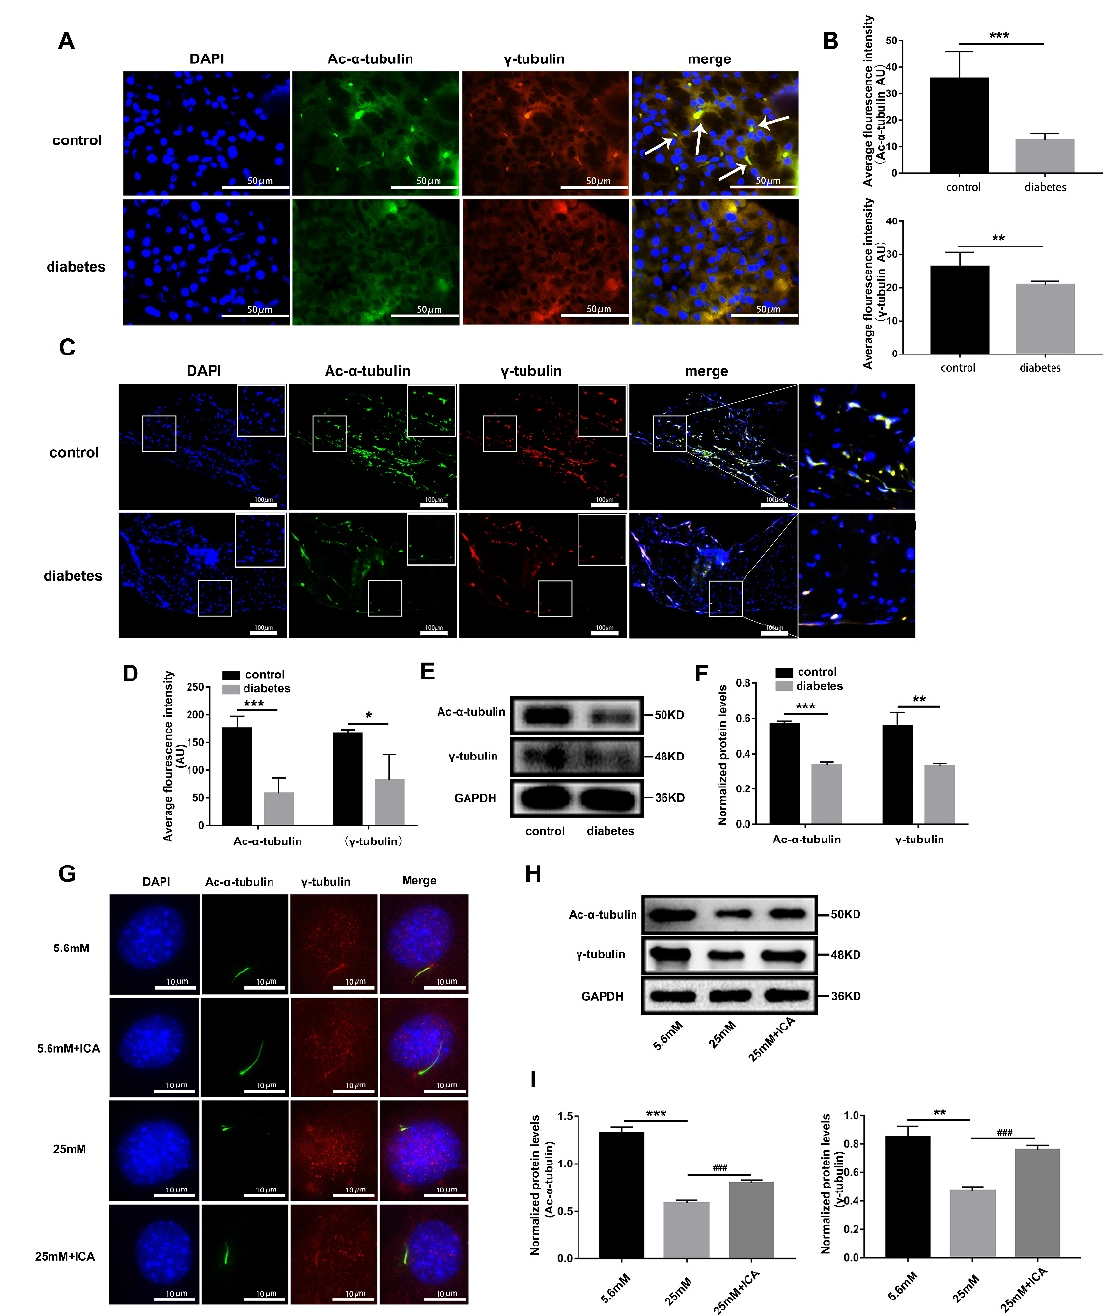
Figure 4. Diabetes impairs primary cilia in bone tissue, and ICA could protect the primary cilia from high glucose damage. ( A ) Immunofluorescence of pancreas, scale bar: 50 μ m. ( B ) Quantitative analysis average fluorescence intensity of Ac- α -tubulin and γ -tubulin in ( A ). ( C ) Immunofluorescence of femur tissue, scale bar: 100 μ m. ( D ) Quantitative analysis average fluorescence intensity of Ac- α - tubulin and γ -tubulin in ( C ). ( E ) Western blot detected the expression of Ac- α -tubulin and γ -tubulin in the femoral protein. ( F ) Quantitative analysis the level of protein expression in ( E ). ICA was added to the diabetic bone loss cell model and induced for 3 days, ( G ) immunofluorescence observed pri- mary cilia. ( H ) Extracted cell total protein, Western blot detects protein expression of Ac- α -tubulin and γ -tubulin. ( I ) Quantitative analysis the level of protein expression in ( H ). * p < 0.05, ** p < 0.01 and *** p < 0.001, compared with 5.6 mM group. ### p < 0.001, compared with 25 mM group.